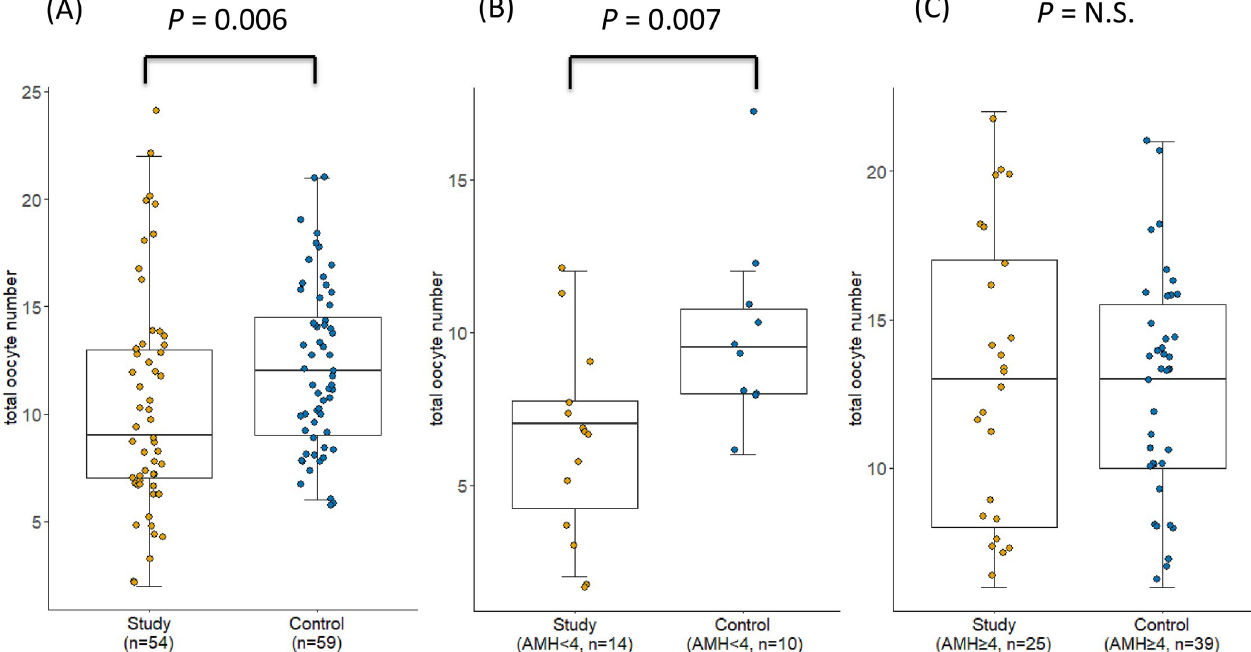
Fig 1. Comparison of total numbers of retrieved oocytes between study and control groups. (A) Total number of retrieved oocytes in IVF was significantly higher in the enrolled women as a whole than in those with a history of salpingectomy. Subgroup analysis of women with (B) AMH < 4 ng/mL and (C) AMH � 4 ng/mL. The study and control groups comprised women with a history of salpingectomy and women without tubal disease, respectively. Values presented as mean ± SD and were provided in the minimal data set of supplementary files. Statistical analysis was conducted by Mann–Whitney U test. P values presented as an actual number when there was a significant difference. N.S: not significant; AMH: anti-Mu¨llerian